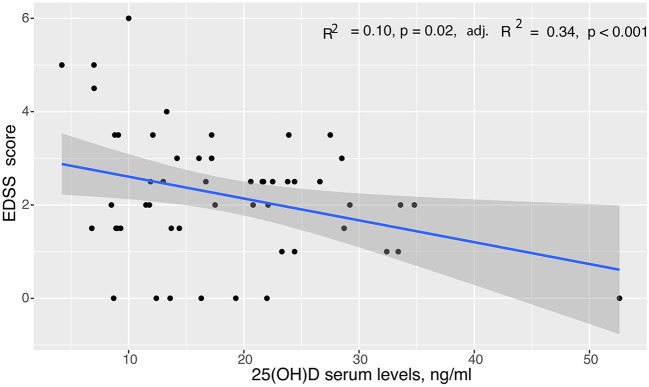
Linear regression analysis of EDSS scores to serum vitamin D levels in the entire cohort with 95% confidence limits. Simple Linear regression showed a significant association between EDSS scores and serum 25(OH)D levels (p = 0.02), which was confirmed after adjustment for age, sex, and disease duration in multiple linear regression analysis (adjusted p < 0.001).